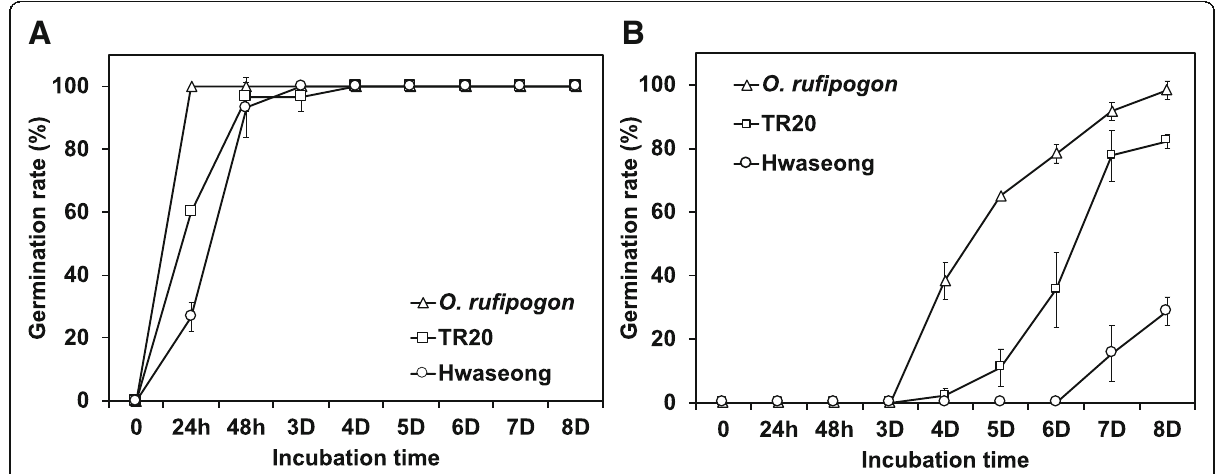
Fig. 1 Germination rate of the parental lines (Hwaseong, O. rufipogon , and TR20) at ( a ) optimal temperature conditions (30 °C) and ( b ) low- temperature conditions (13 °C) for 8 days after incubation. Triangle, square, and circle indicate means of germination rate for O. rufipogon , TR20, and Hwaseong, respectively. Error bars indicate standard